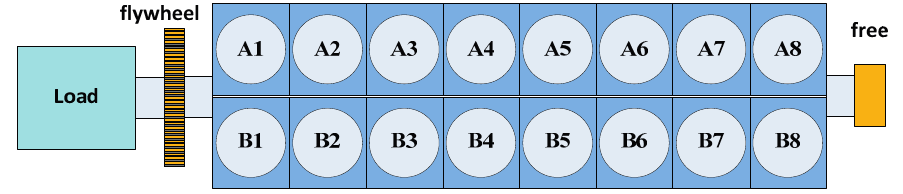
Figure 6. Structure of the diesel